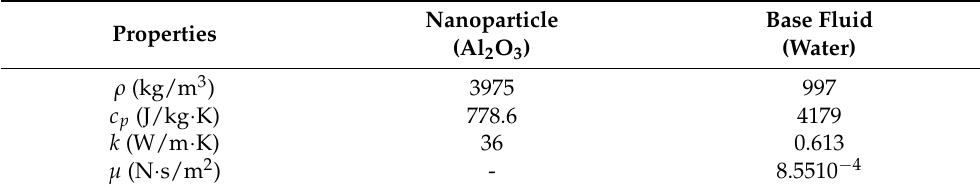
Table 4. Thermophysical properties of nanofluid